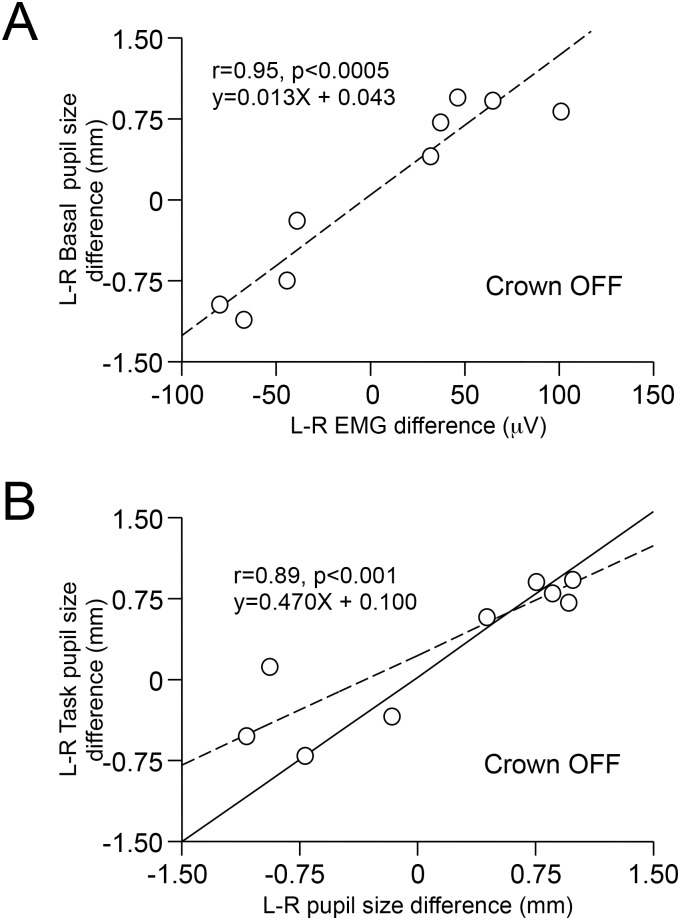
EMG and pupil’s size asymmetries in CROWN OFF condition.A. Relation between the left-right difference in pupil size measured with the arches in contact (CROWN OFF) and the subject not attending any task (Basal) and that in masseter EMG activity observed with the arches in contact (CROWN OFF) during bite. B. Relation observed in CROWN OFF between the left-right difference in pupil size measured during the haptic task and that observed in basal condition. The continuous line represents equal values of basal and task pupil’s asymmetries. In both A and B, dotted lines are the regression lines of the plotted points and their equations and coefficient of correlations are indicated in the insets.